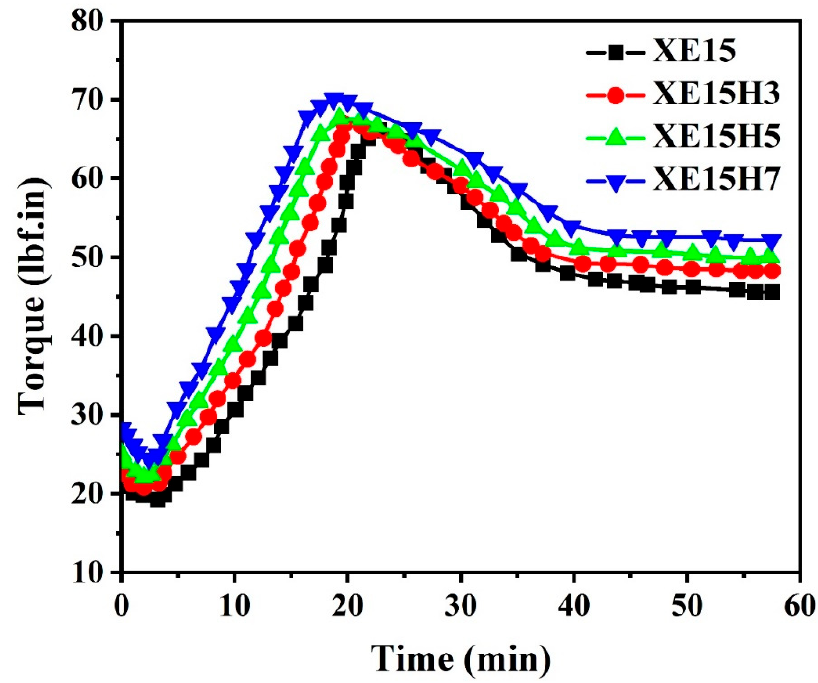
Figure 1. Cure behavior of various XNBR / epoxy / XHNT s nanocomposites. Table 2. Cure characteristics of various XNBR / epoxy / XHNTs nanocomposites. Sample Code 𝑀 ℎ (lb f .in) a